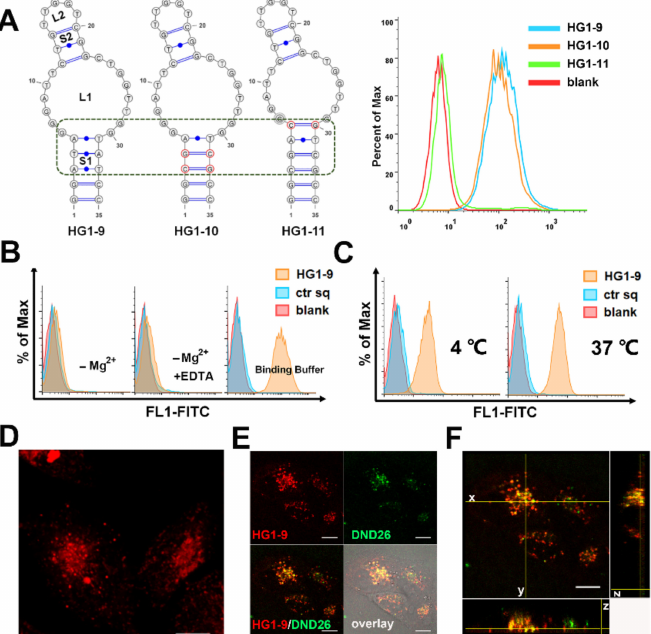
Figure 3. Characterization and optimization of HG1-9. ( A ) The predicted secondary structures of HG1-9, and its mutated sequences HG1-10 and HG1-11; and flow cytometry analysis of their binding to Jurkat cells. ( B , C ) The binding conditions that affect HG1-9 binding to Jurkat cells. HG1-9 incubated with cells at 4 ◦ C in different buffers: PBS with 5 mM MgCl 2 , PBS without MgCl 2 and PBS with 5 mM EDTA ( B ). HG1-9 incubated with cells at temperatures of 4 and 37 ◦ C in the binding buffer ( C ). Blank represents Jurkat cells without any treatment, ctr sq was the negative control. ( D ) 2D projection of the maximum intensity from axial (Z) dimension of fluorescence of HG1-9 (10 nM, labeled by TAMRA) within HeLa cells after incubation for 4 h at 37 ◦ C. ( E ) Confocal imaging of HeLa cells co-stained by HG1-9 (labeled by TAMRA) and green Lysotraker (DND-26) at 37 ◦ C for 30 min. ( F ) 3D images of HeLa cells in ( E ), the images respectively represent x–y plane, x–z plane and y–z plane. The scale is 10 µ